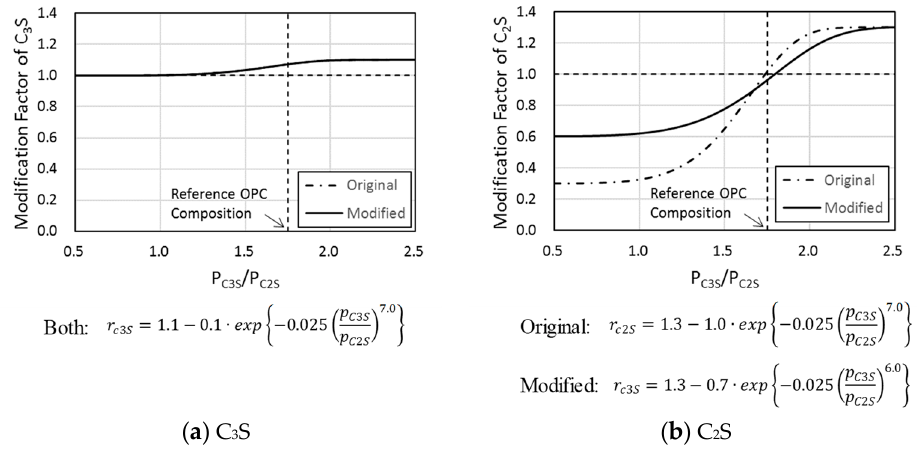
Figure 10. Modification factors of the heat generation rate for C 3 S and C 2 S.